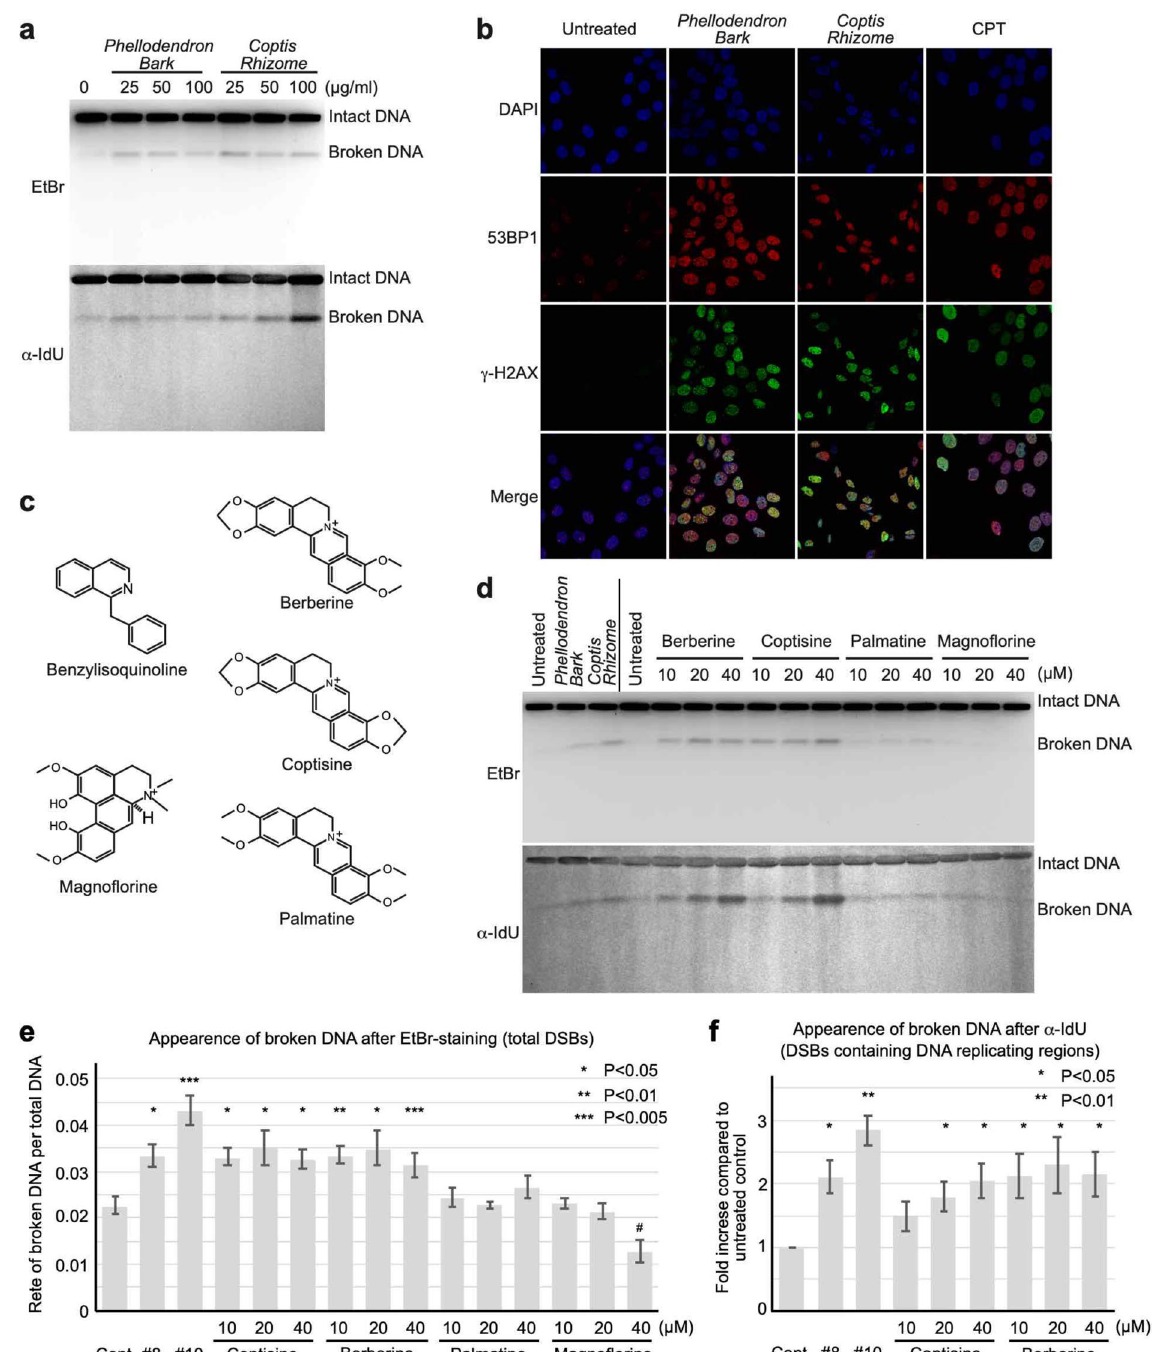
Figure 1. Screening of herbal extracts and characterization of berberine and coptisine. ( a ) PFGE analysis of DSB accumulation after treatment with extracts of Phellodendron Bark and Coptis Rhizome . Total broken DNA was detected by ethidium bromide (EtBr) staining, whereas DSBs at DNA replication sites were detected by immunoblotting with the anti-BrdU antibody. ( b ) Immunofluorescence analysis of DSB accumulation by detecting the DSB markers γ-H2AX and 53BP1 foci. ( c ) Molecular structures of the BIAs berberine, coptisine, palmatine, and magnoflorine. ( d ) PFGE analysis of DSB accumulation after treatment with berberine, coptisine, palmatine, and magnoflorine. ( e ) Quantification of broken DNA. The data are presented as the ratios of the amount of broken DNA per total DNA (intact DNA + broken DNA). ( f ) Quantification of broken DNA. The data are presented as fold inductions relative to the untreated